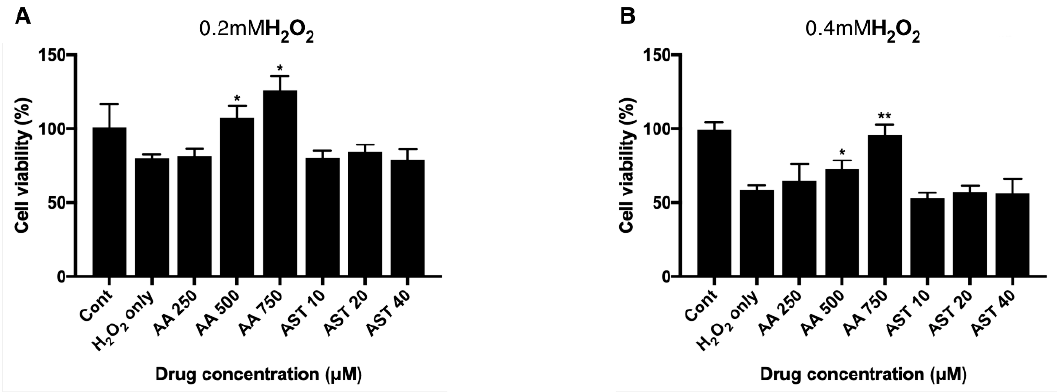
Figure 4. E ff ect of ascorbic acid and astaxanthin on H 2 O 2 -induced oxidative stress model of ARPE-19. The e ff ect of various concentration of ascorbic acid or astaxanthin (pretreated for 6 h and co-treated with H 2 O 2 for 24 h) on the response of ARPE-19 cells to sublethal dose of 0.2 mM ( A ) or lethal dose of 0.4 mM H 2 O 2 ( B ). The cell viability was determined by MTT assay. Treatment of ascorbic acid (500–750 µ M) significantly increased ARPE-19 cell viability following 0.2 mM H 2 O 2 exposure. However, astaxanthin (10–40 µ M) did not significantly a ff ect the cell viability ( A ). Ascorbic acid (500–750 µ M) also significantly increased the cell viability under 0.4 mM H 2 O 2 but astaxanthin (10–40 µ M) did not have significant e ff ect on the viability ( B ). Asterisks indicate a significant increment in cell viability compared with cells treated with H 2 O 2 only (* p < 0.05, ** p < 0.01). AA, ascorbic acid; AST, astaxanthin; MTT, 3-(4,5-dimethylthiazol-2-yl)-2,5-diphenyltetrazolium